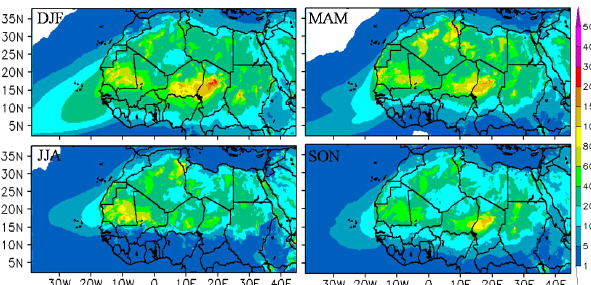
Table 3. Mean dust wet